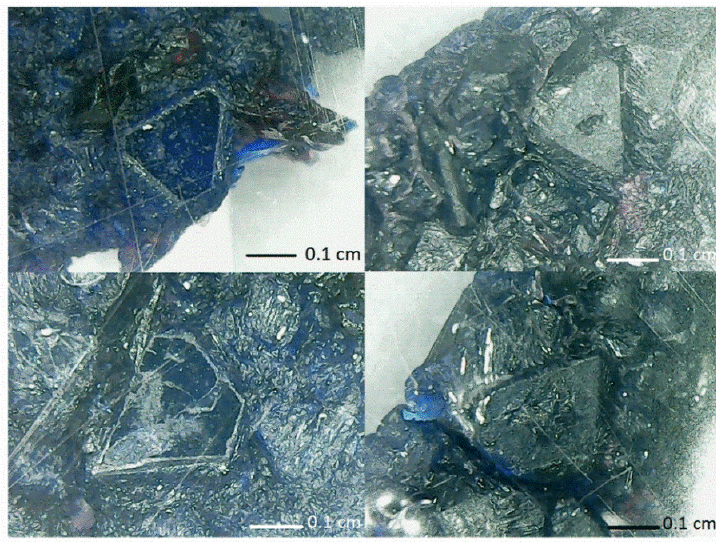
Figure 5. View of crystals without UV assistance by digital microscopy.